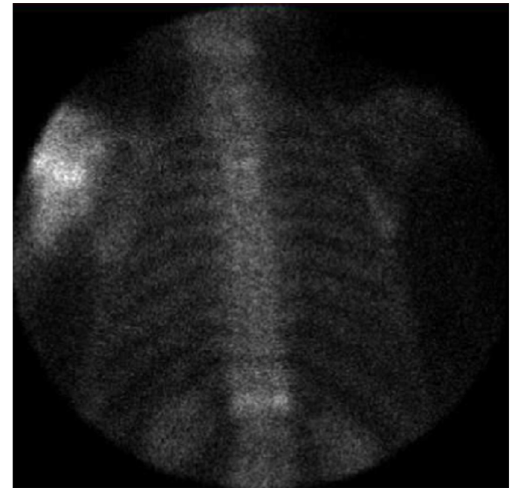
Figure 4. Bone scan (patient 1): excessive accumulation in the mineralization phase in the left